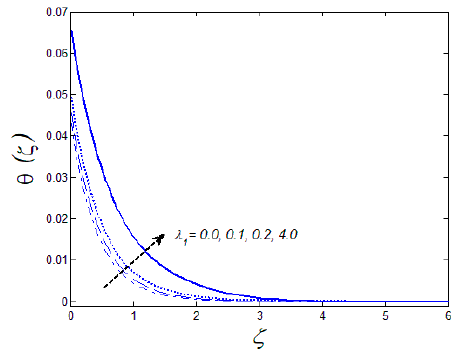
Figure 9. Upshot of λ 1 on temperature distribution θ ( ζ ) .